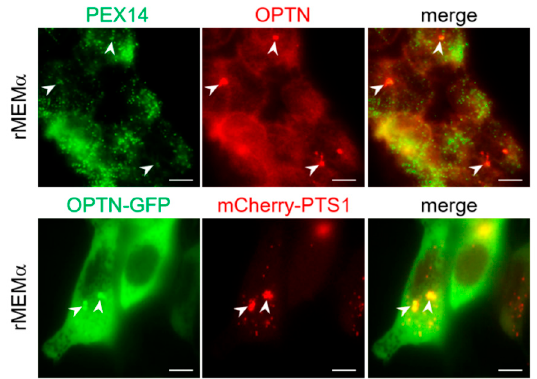
Figure 12. Endogenous and GFP-tagged OPTN can be recruited to peroxisomes under basal growth conditions. DD-DAO Flp-In T-REx 293 cells were co-transfected ( lower panels ) or not co-transfected ( upper panels ) with plasmids encoding OPTN-GFP and mCherry-PTS1. After culturing the cells for two days in rMEM α , they were processed for live-cell imaging ( lower panels ) or fixed and processed for immunofluorescence microscopy using a mouse antiserum against PEX14 and a rabbit antiserum against OPTN, in combination with goat anti-mouse and anti-rabbit secondary antibodies conjugated to Alexa Fluor 488 and Texas Red, respectively ( upper panels ). The white arrowheads point to sites of colocalization between OPTN(-GFP) and the peroxisomal marker protein PEX14 or mCherry-PTS1. Scale bar, 10 µm.